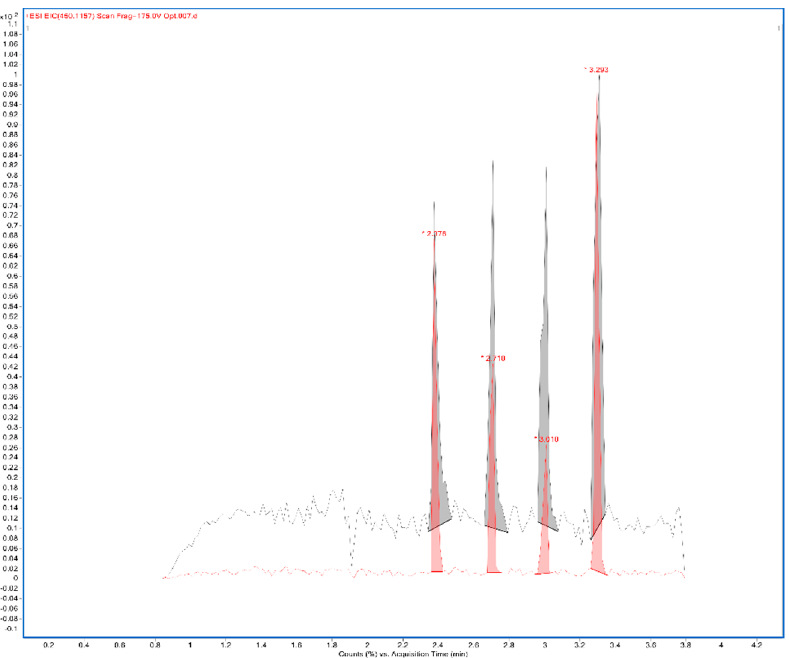
Figure 2. Extracted mass 450.1157 from the chronogram of 2% CMC sample (CMC: carboxymethyl- cellulose).